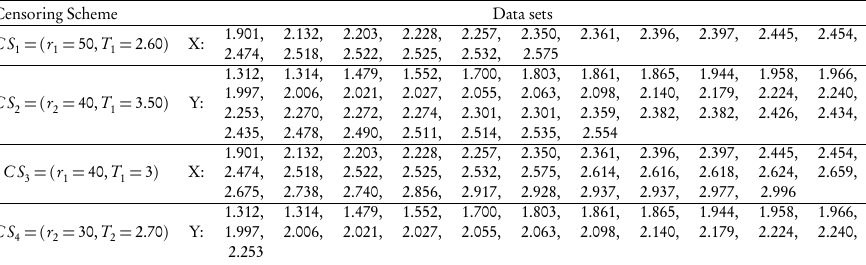
The generated hybrid censored samples corresponding to real data sets. Censoring Scheme Data